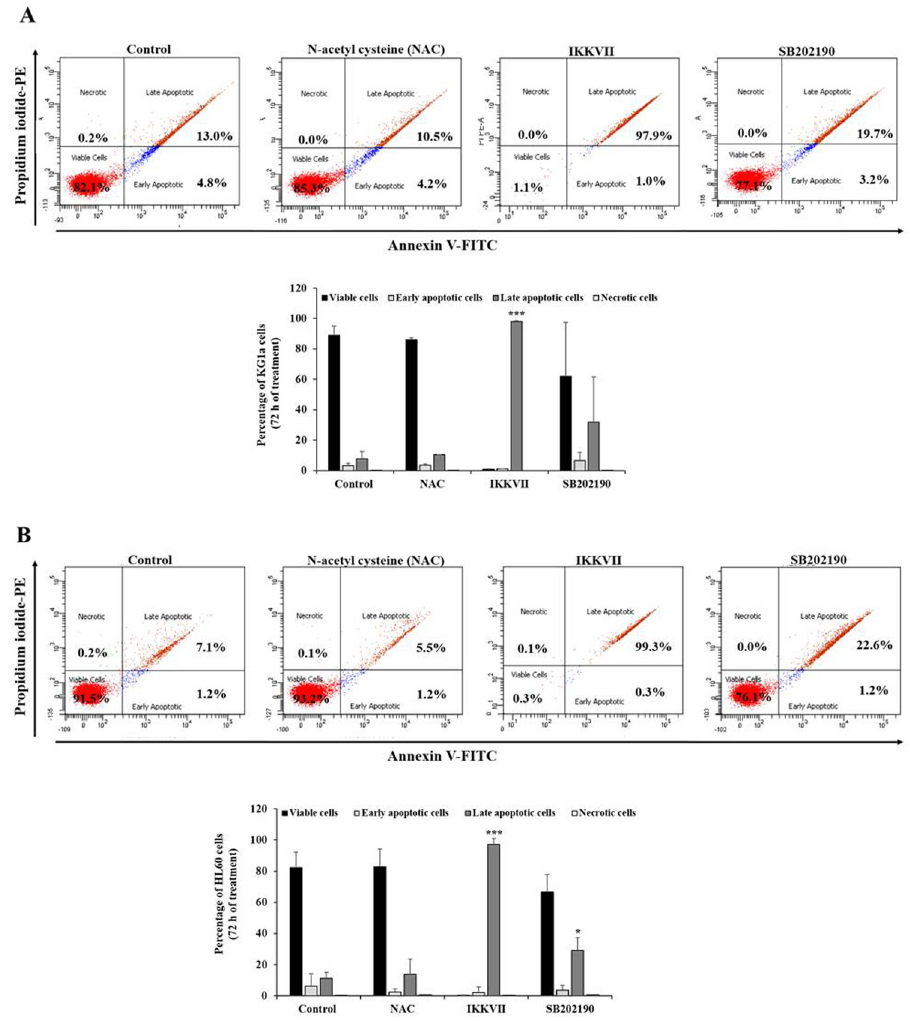
Fig 2. KG1a and HL60 apoptotic status after cell treatment with NAC (ROS production inhibitor), IKKVII (NF- kB pathway inhibitor), and SB202190 (p38 MAPK pathway inhibitor). The KG1a (A) and HL60 (B) cells were treated with 5 mM NAC, 20 μ M IKKVII and 10 μ M SB202190. After 72 h incubation, viable, (early and late) apoptotic, and necrotic status of the cells were determined using Apoptosis determination kit. Representative cell scatter plots indicating the percentage of cells determined at each status. Bar graphs showing the results presented as mean ± SD, based on three independent experiments. � p < 0.05, ��� p < 0.001, and ���� p < 0.0001 vs . control. determined based on the Annexin V-FITC/PI-PE double staining after 72 h incubation. The KG1a cell pre-treatment with the ROS scavenger NAC tested at a concentration of 5 mM reported to prevent ROS generation [38, 39], no significant change of the apoptotic status of the KG1a cells was observed, compared with the apoptotic status determined in the untreated KG1a cells (Fig 2A). The KG1a cell treatment with 20 μ M IKKVII resulted in the induction of apoptosis, displaying an 85% increase of late apoptotic cells, and 10 μ M SB202190 prompted apoptosis, revealing a 7% increase of late apoptotic cells, as compared with apoptotic status determined in the untreated KG1a cells (Fig 2A). For the HL60 cells, similar pro-apoptotic effects as in the KG1a cells were observed in the HL60 cells, which displayed a higher apoptosis percentage, including 99% and 20% of the cell population in late apoptosis, reached after the